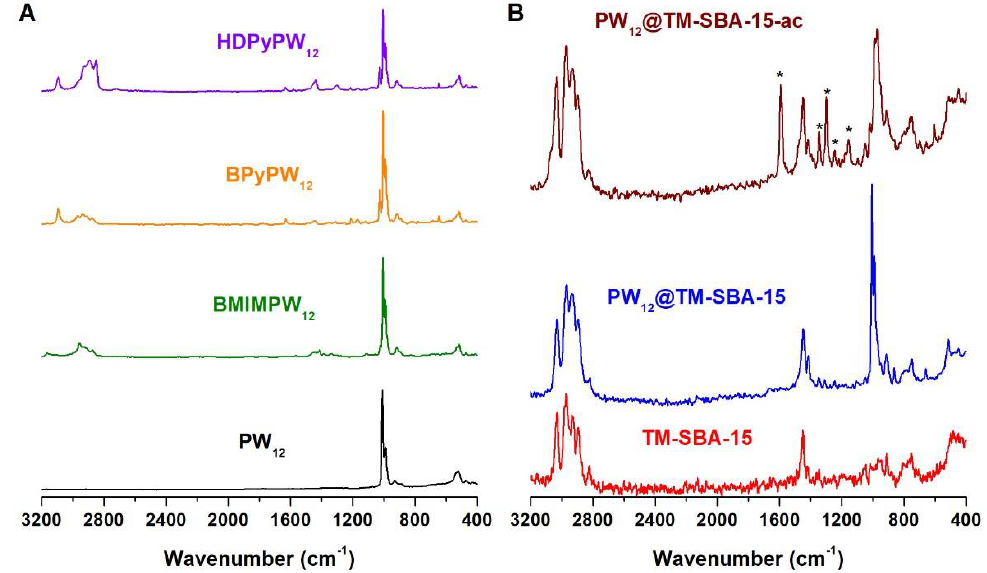
Figure 1. FT-Raman spectra of ( A ) the PW 12 -hybrids and ( B ) the amine-functionalized TM–SBA-15 and the corresponding PW 12 @TM–SBA-15 composite before and after catalysis. Asterisks (*) denote bands associated with organosulfur compounds that remained adsorbed to catalysts.